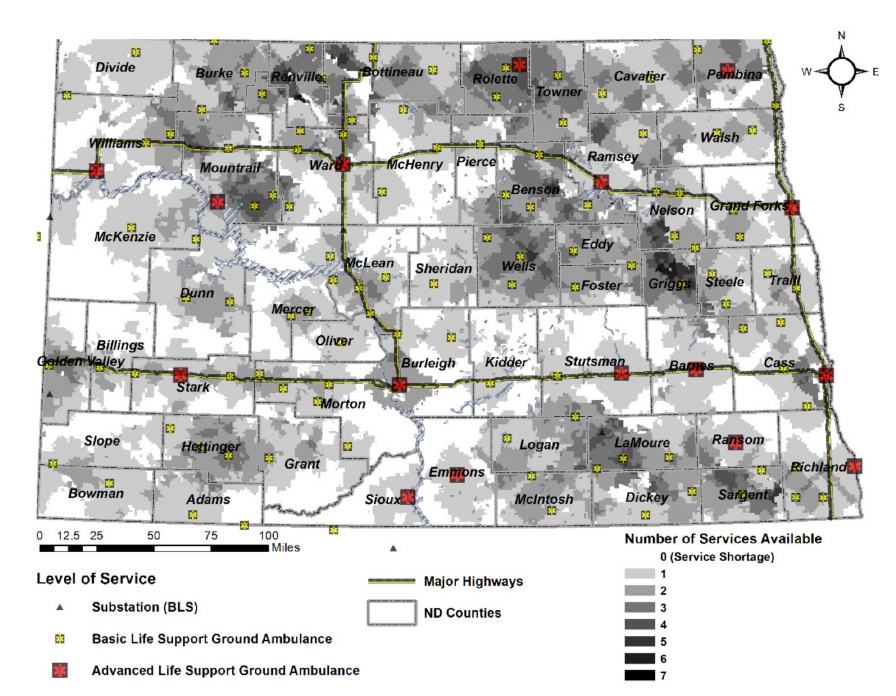
Figure 3. Service map with service shortage (=0) and multiple ambulance services available ( ≥ 2) per Scenario